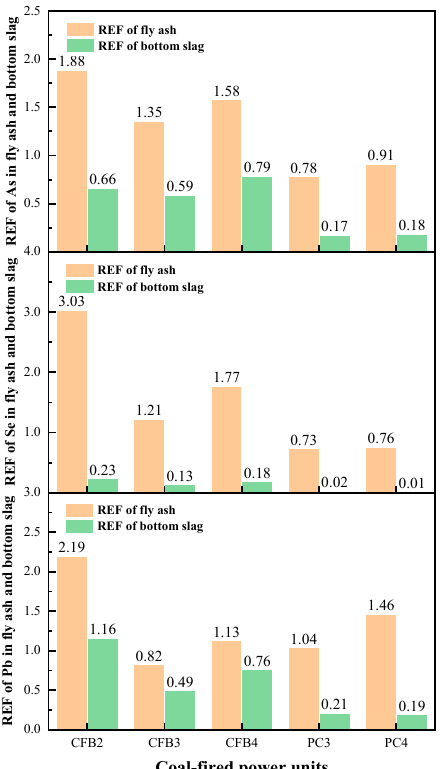
Figure 3. REFs of As, Se and Pb in fly ash and bottom slag of coal-fired power units.